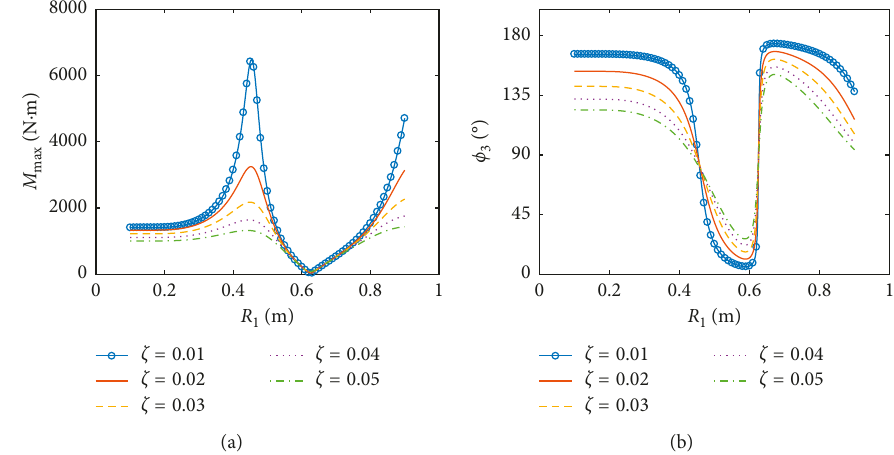
Figure 9: The amplitudes and the phases of resultant moment versus the inner radius of the flexible baffle for z (a) the amplitude of the resultant moment, (b) the phase of the resultant